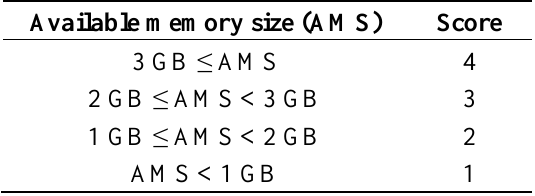
Table 3. The score table of available memory sizes.